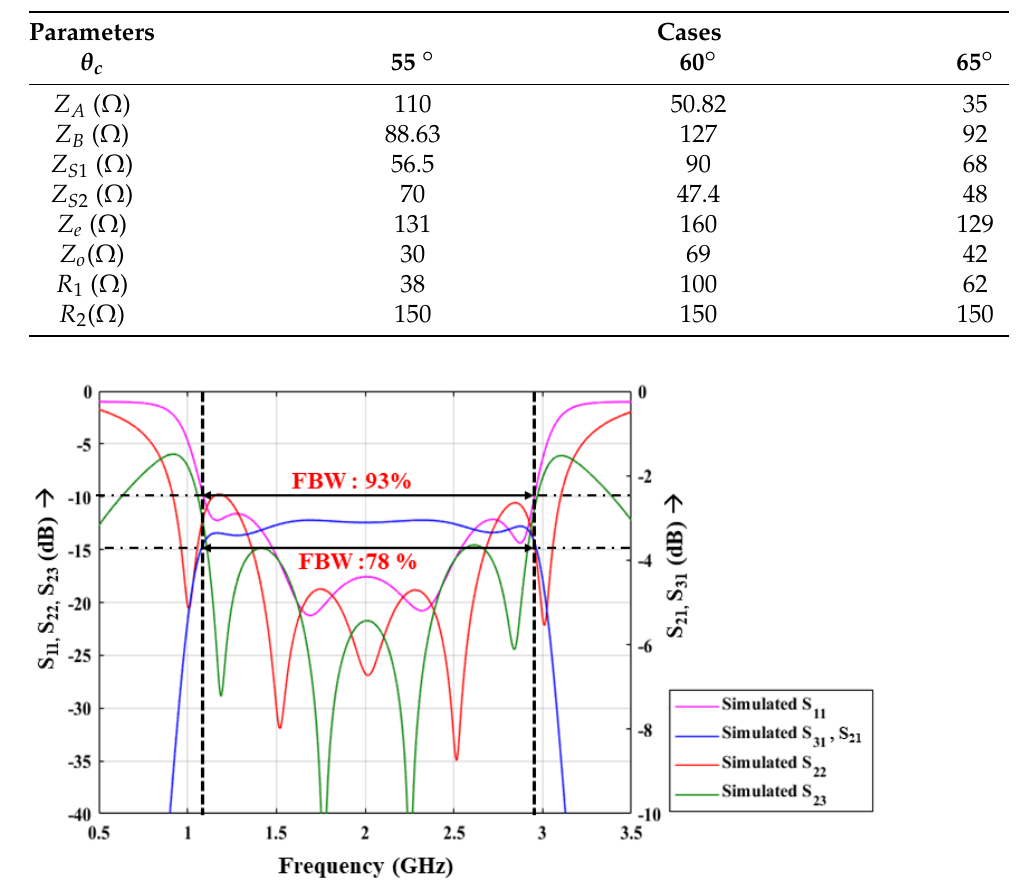
Table 2. Design Parameters of DC Isolated WB WPD.